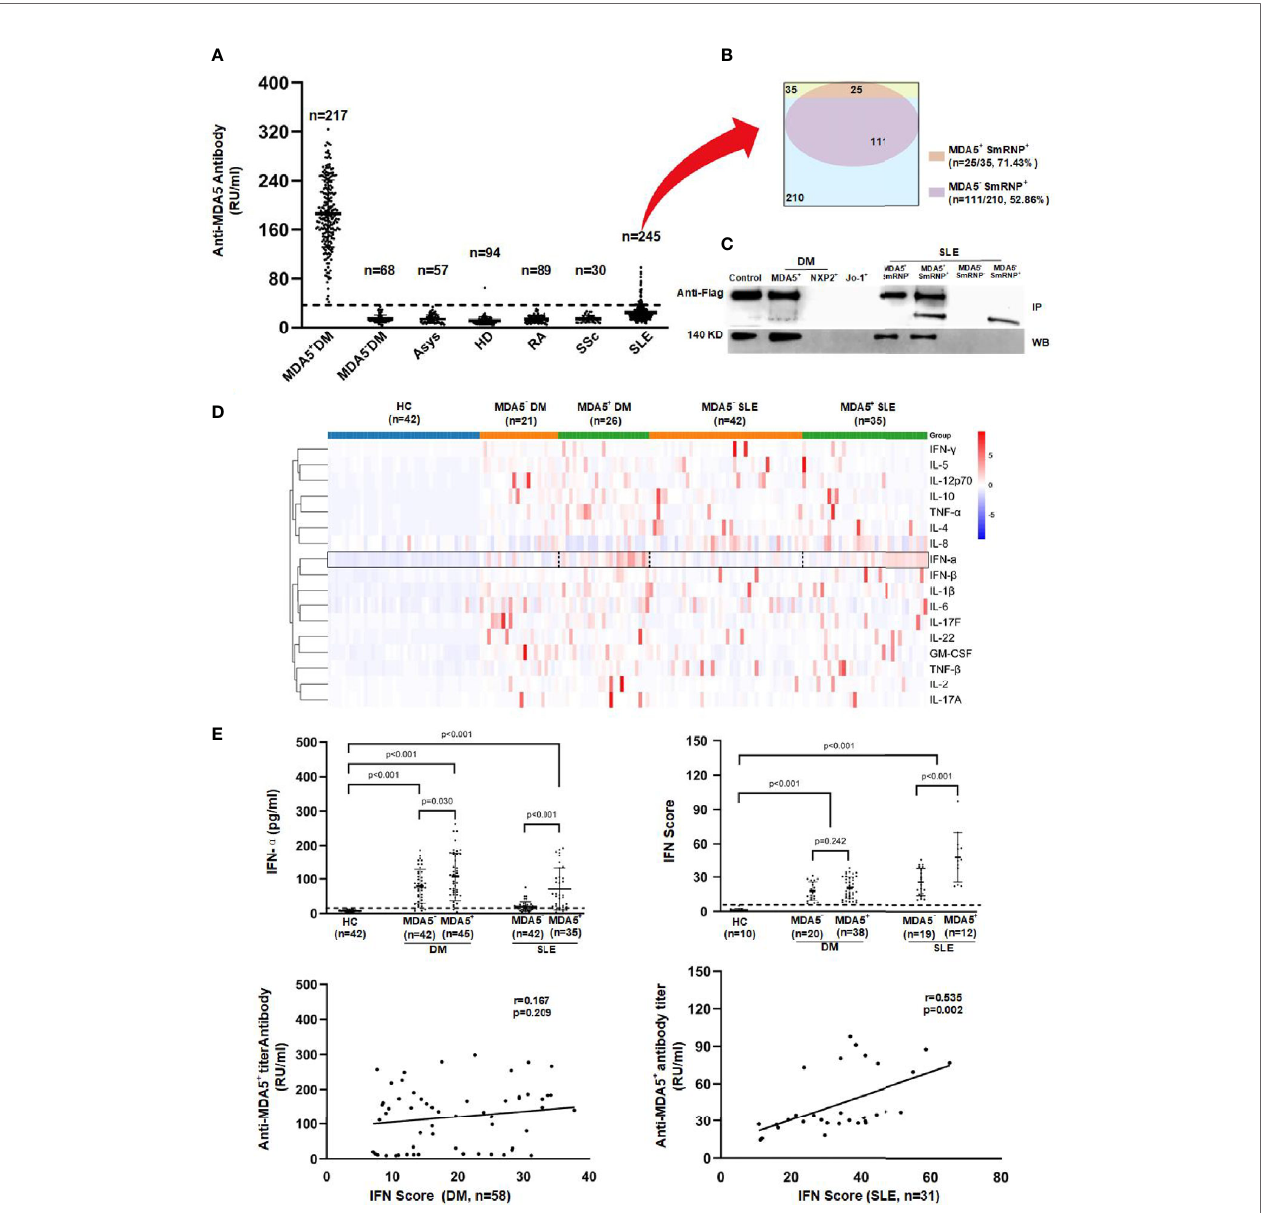
FIGURE 1 | Anti-melanoma differentiation-associated gene 5 (MDA5) autoantibody and cytokine pro fi ling in dermatomyositis (DM) and systemic lupus erythematosus (SLE) patients. (A) Quantitative anti-MDA5 measured by ELISA in anti-MDA5 + DM, MDA5 − DM ( n = 68, anti-Mi-2 a / b = 13, anti-NXP2 = 17, anti-SAE1 = 15, anti- TIF1 g = 23), anti-synthase syndrome (ASyS; n = 57, anti-Jo-1 = 10, anti-PL-7 = 12, anti-PL-12 = 12, anti-EJ = 10, anti-OJ = 13), SLE, systemic sclerosis (SSc), and rheumatoid arthritis (RA) patients and in healthy donors. The dotted line represents the cutoff value (35 RU/ml) of the anti-MDA5 antibody titer. (B) Overlaps among the anti-MDA5 and anti-SmRNP antibodies in SLE patients. (C) Immunoprecipitation (IP, upper ) and Western blotting (WB, lower ) were performed to validate the anti-MDA5 ELISA results (representative of more than fi ve independent experiments). (D) Heat map of the cytokine expression pro fi ling of DM and SLE patients. (E) Serum interferon alpha (IFN- a ) and peripheral blood mononuclear cell (PBMC) IFN-inducible genes were measured by ELISA and SYBR green qRT-PCR, respectively. The dotted line represents the cutoff value (mean + 3SD of the values of healthy donors) of the serum IFN- a and IFN